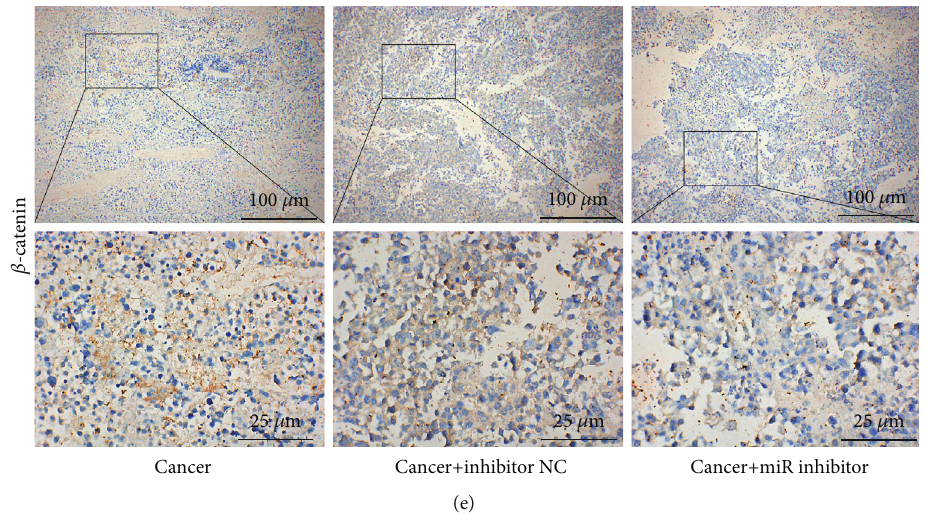
Figure 4: The miR-126 inhibitor inhibited the tumor growth of hepatoblastoma. Mice were divided into the cancer, cancer+inhibitor NC, and cancer+miR inhibitor groups. (a) The tumor tissues of mice were collected, pictured, and weighted after mice were sacri fi ced. (b) The ratio of CD44+ CD90+ CD133+ cells was measured by fl ow cytometry. (c) Oct4, SRY, IL-1 α , IL-6, and TGF- β 1 levels in tissues were investigated by RT-qPCR. (d) β -catenin and ERK levels in tissues of mice were assessed by western blotting. β -Actin was applied for normalization. (e) The expressions of β -catenin were assessed by IHC staining. ∗ P < 0 : 05 compared to